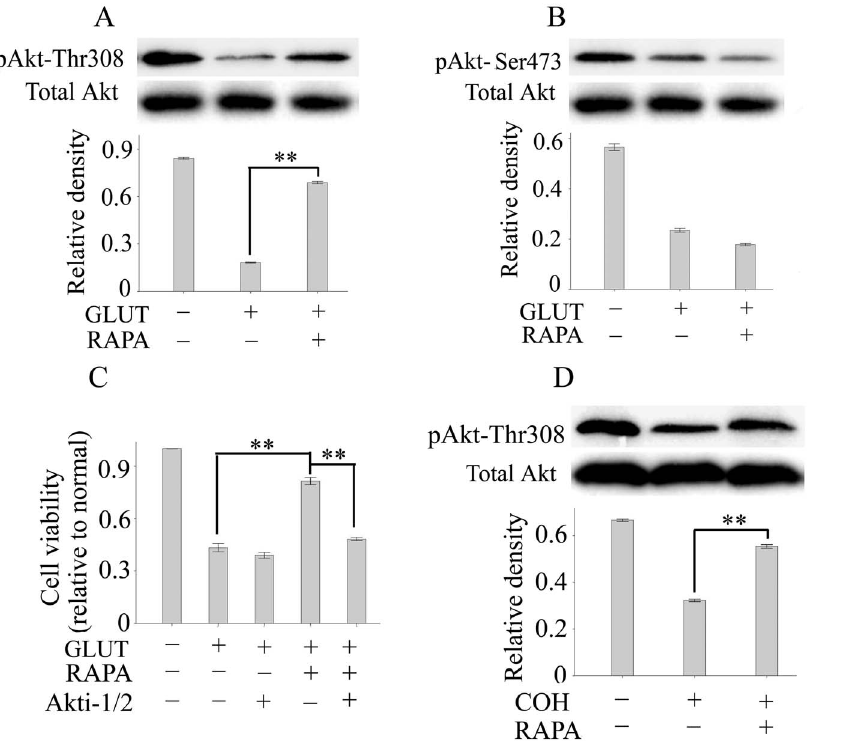
Figure 6. Inhibition of Akt dephosphorylation is implicated in rapamycin-mediated neuroprotection in primary RGCs and the COH. Akt phosphorylation at sites Thr308 (A) and Ser473 (B) in primary RGCs was determined by western blotting. (C): The cell viability of primary RGCs was measured by MTT assay. (D): Akt phosphorylation at Thr308 in retinas was measured by western blotting. Values are presented as the mean 6 SEM of 3 replicates, and experiments were repeated at least 2 times with similar results. ** p , 0.01. Abbreviations: GLUT, glutamate; RAPA, rapamycin; Akti-1/ 2, an Akt inhibitor.